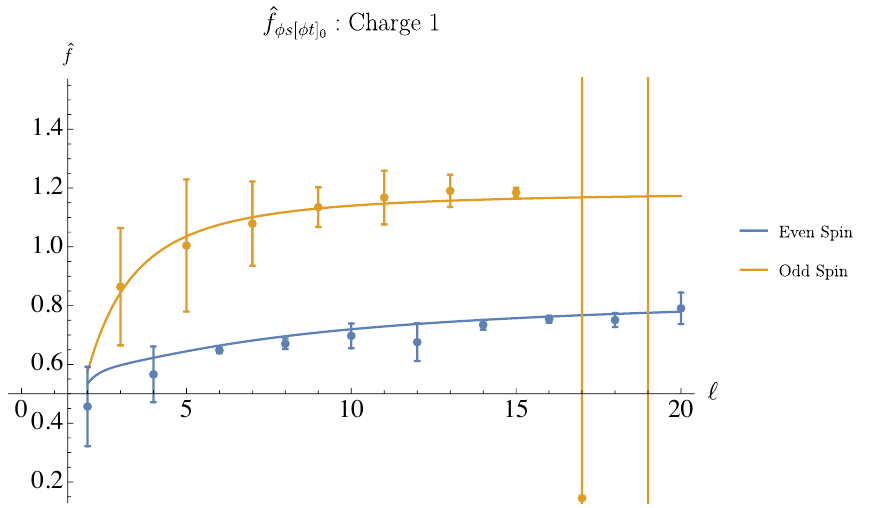
Figure 10 . Analytic and numerical predictions for \diagonal" three-point coe(cid:14)cients between external operators (cid:30) , t and operators on the double-twist trajectories [ (cid:30)t ] 1 even and odd spin. The blue curve represents the even-spin trajectory while the orange curve represents the odd-spin trajectory. We divide each coe(cid:14)cient by the corresponding coe(cid:14)cient in Mean Field Theory (MFT).